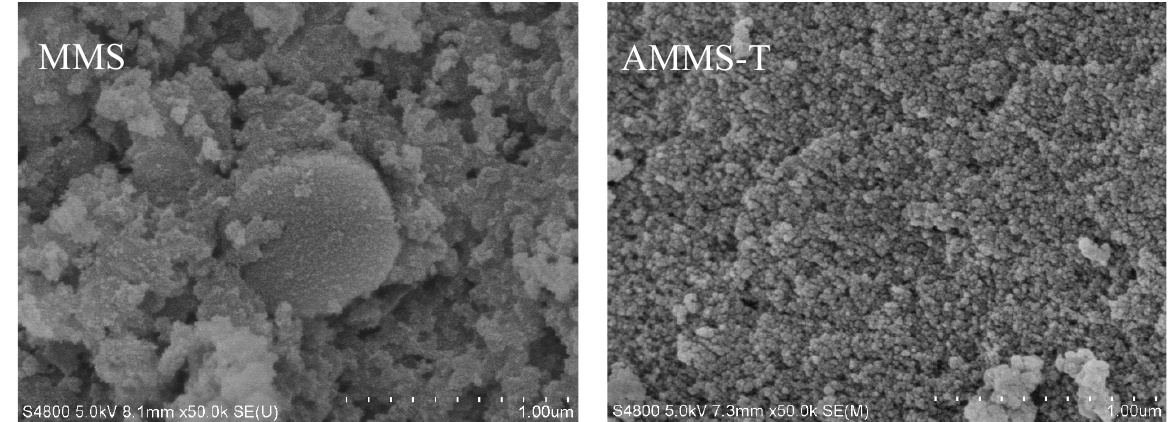
Figure 2. SEM images of MMS and AMMS-T.